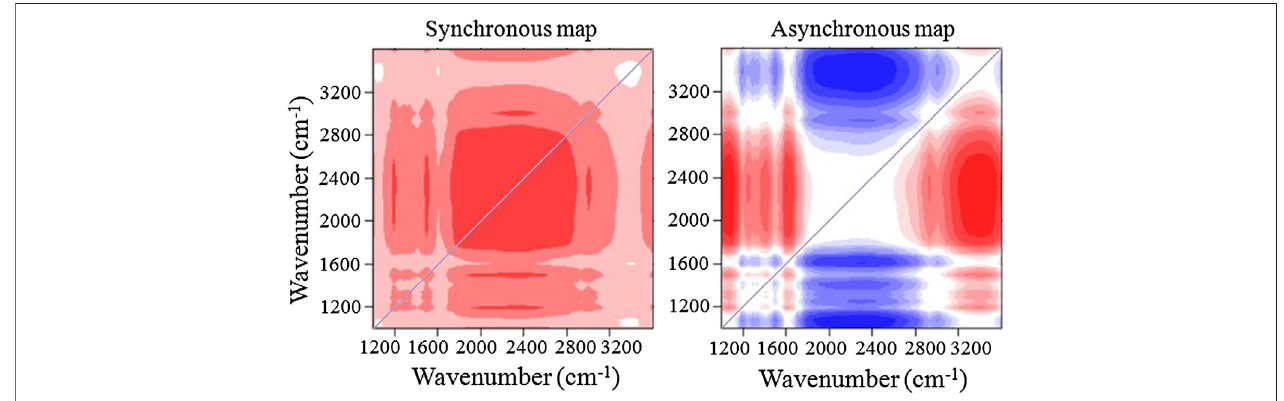
FIGURE 5 | 2D-COS analysis obtained by FTIR of DOM-Cu(II). The red regions show positive correlations, and the blue regions show negative correlations. An increase in the intensity of a particular color represents a stronger positive or negative correlation.